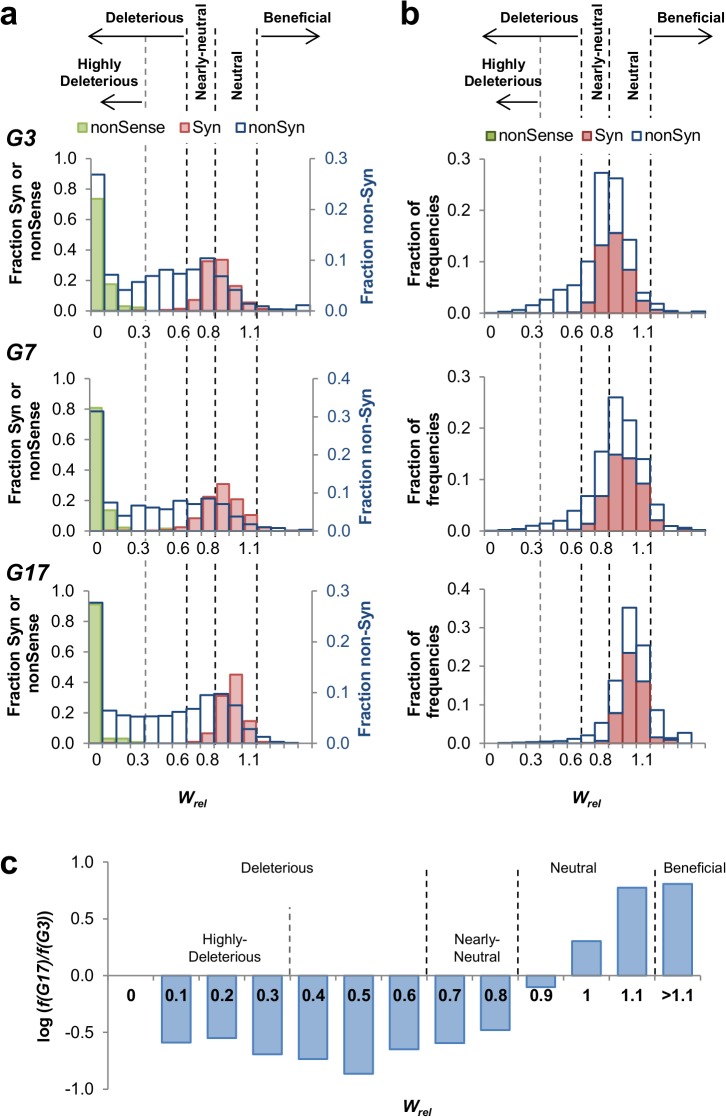
The distribution of fitness effects of mutations in M.HaeIII's drift.
a. The distributions of fitness effects of all mutations observed in the sequenced rounds of the drift (G3, G7 and G17) by their relative fitness values, W
rel. Mutations were binned by unit interval values of W
rel = 0.1, ranging from W
rel = 0 to > 1.4 (missense: n = 1,957; nonsense: n = 125; synonymous: n = 321). b. Distribution of the frequencies of mutations within each given range of W
rel values. The frequencies of all mutations within a given W
rel range were summed up and divided by the sum of frequencies for all mutations within the same round. c. Log-values of the fold changes in the frequencies per each W
rel range in G17 relative to G3.